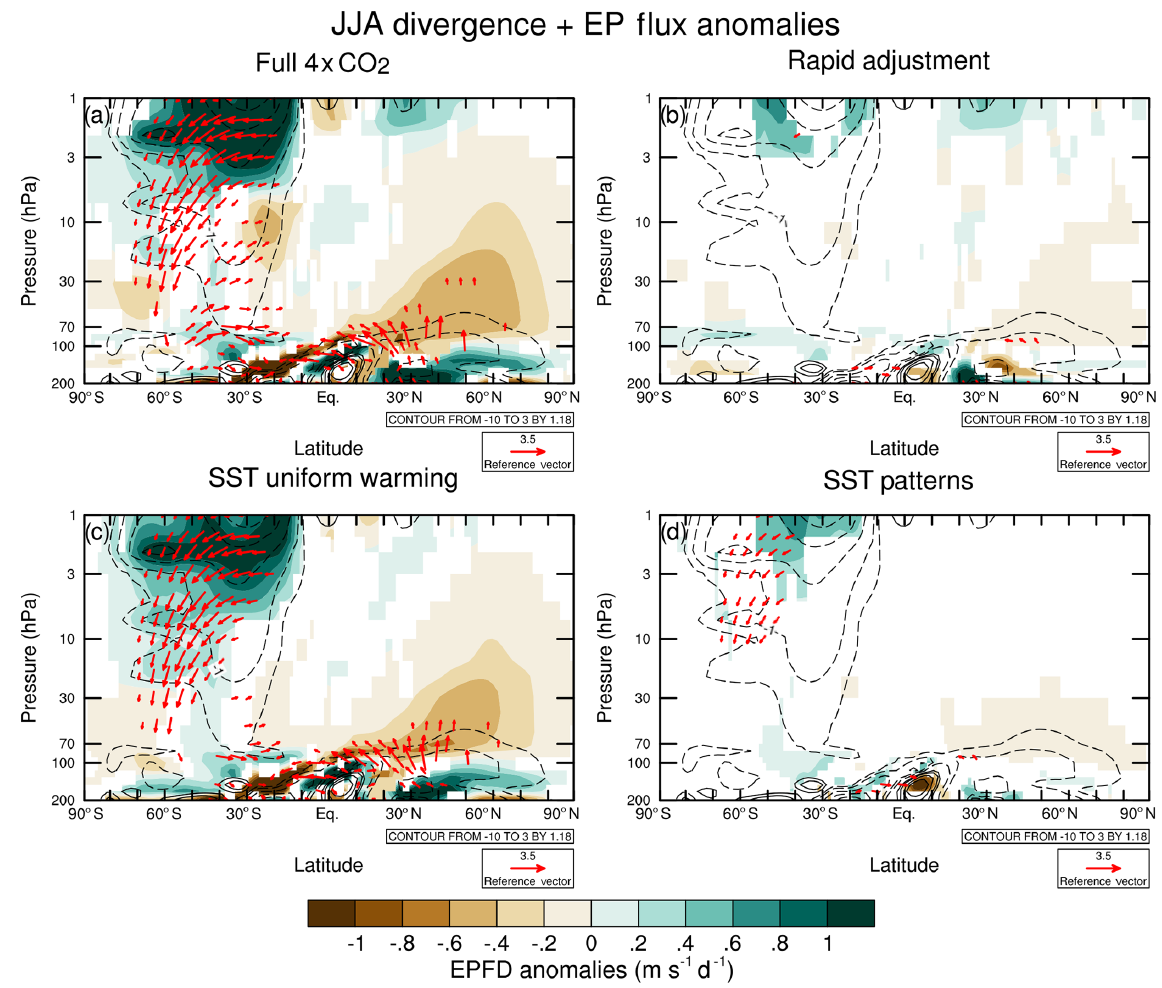
Figure 8. As in Fig. 7, but for the JJA season.